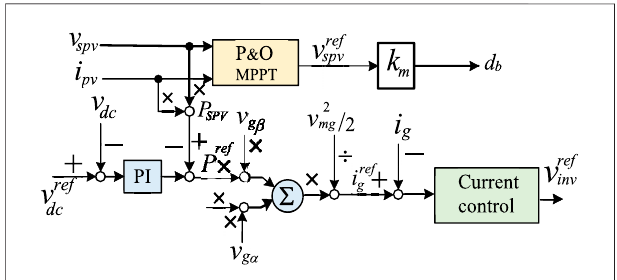
FIGURE 8 | Inverter control block with PI and current